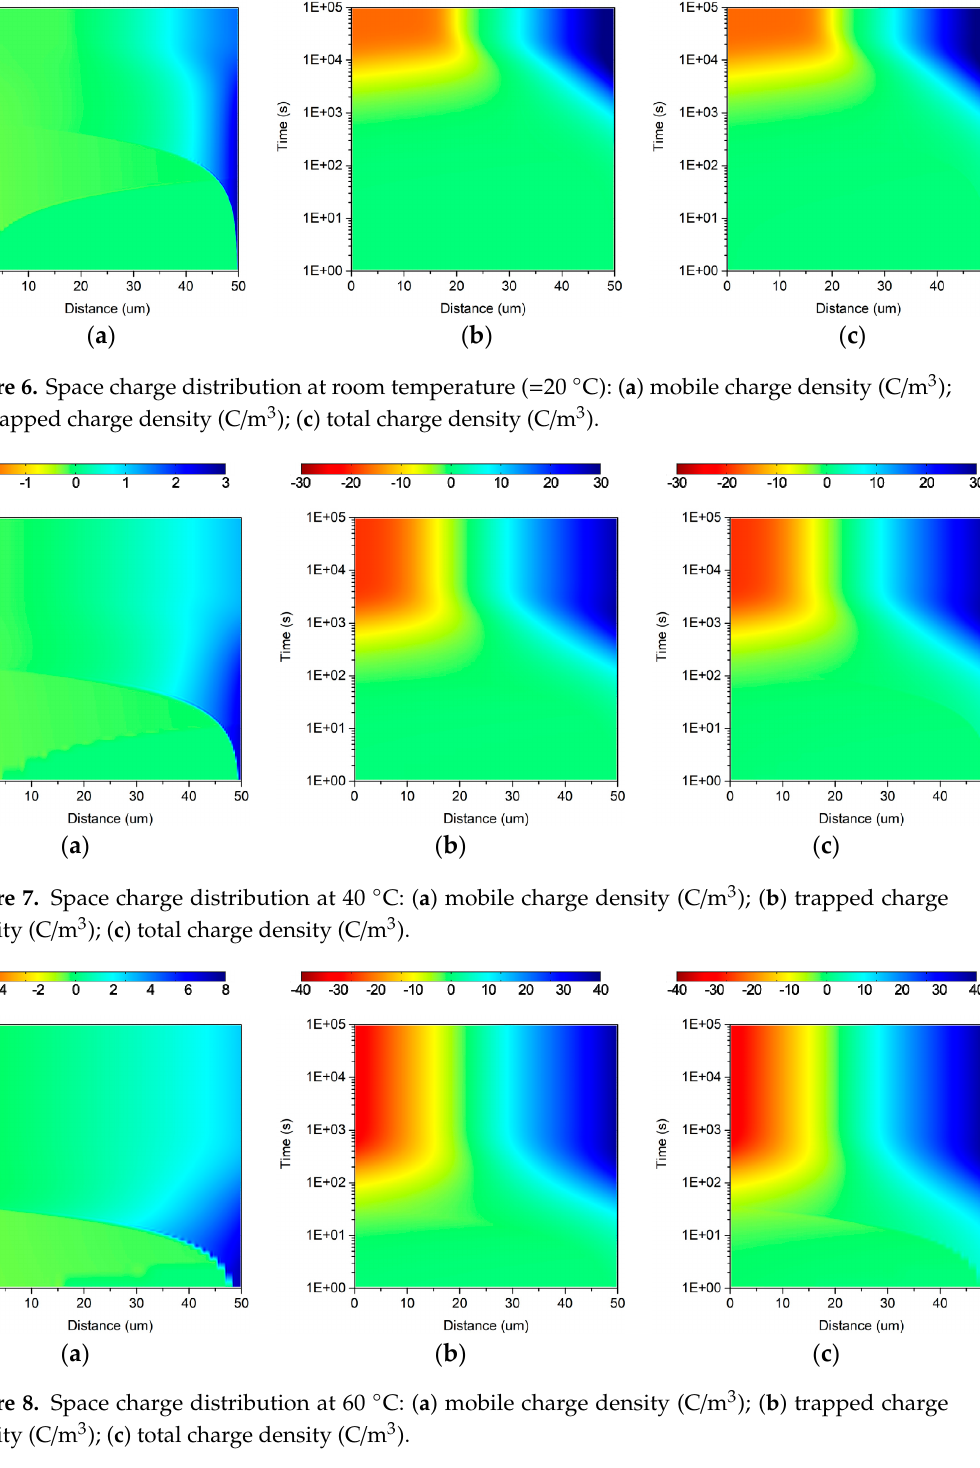
Figure 8. Space charge distribution at 60 °C: ( a ) mobile charge density (C/m 3 ); ( b ) trapped charge density (C/m 3 ); (c) total charge density (C/m 3 ).